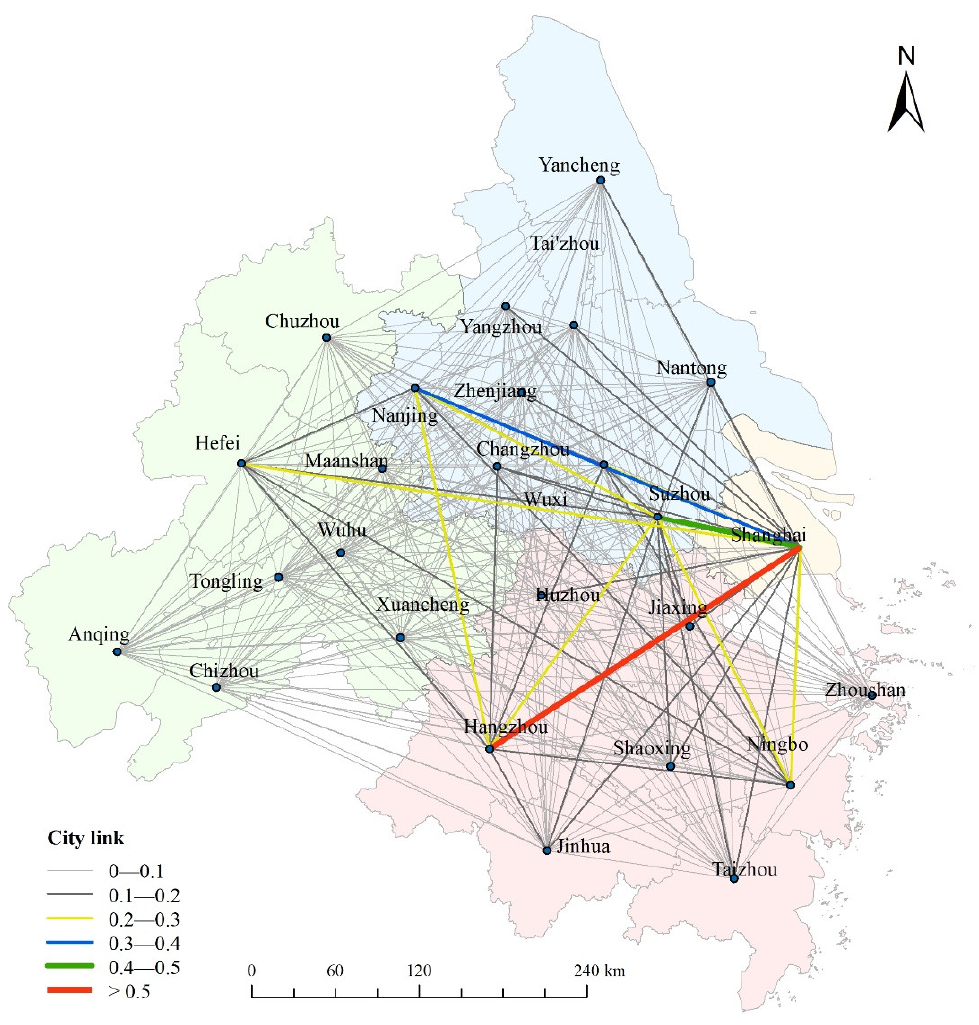
Figure 3. Cities’ spatial linkages in the YRDUA in 2019.